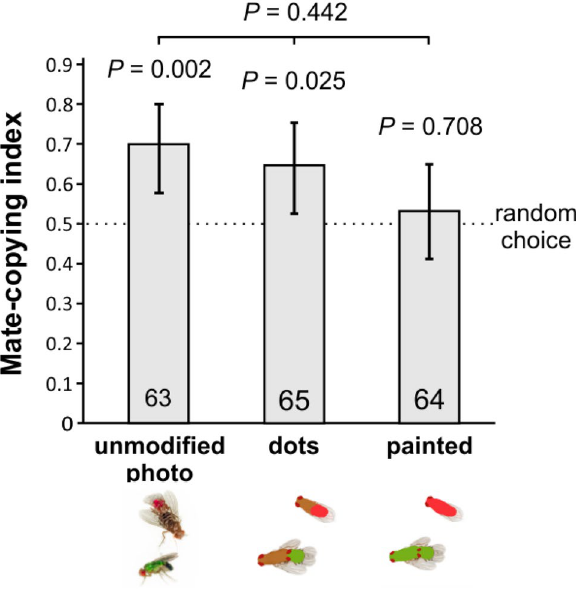
Figure 5. Effect of modification of colour patterns on mate copying. All treatments include a mixture of lateral or top views of the copulating pair. Statistics above bars: P values of the binomial tests of departure from random choice (represented by the dashed line); above the horizontal bars: P values of binomial tests of a GLMM testing the treatment effect within each panel. Error bars: Agresti-Coull 95% confidence intervals. For examples of the pictures used see Fig.